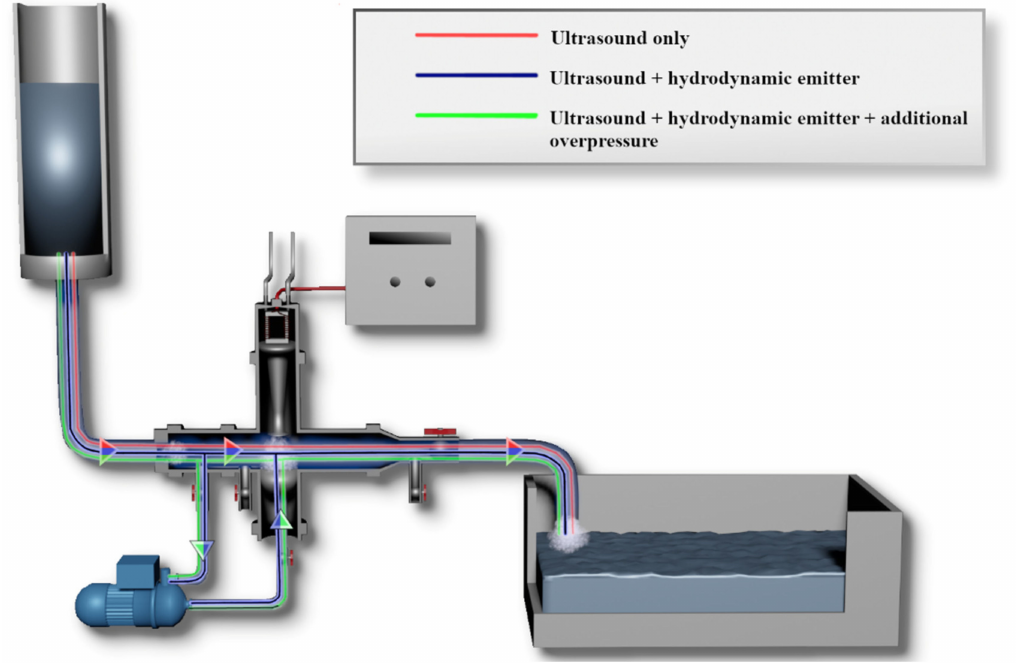
Figure 2. The flows of the treated liquid during the di ff erent